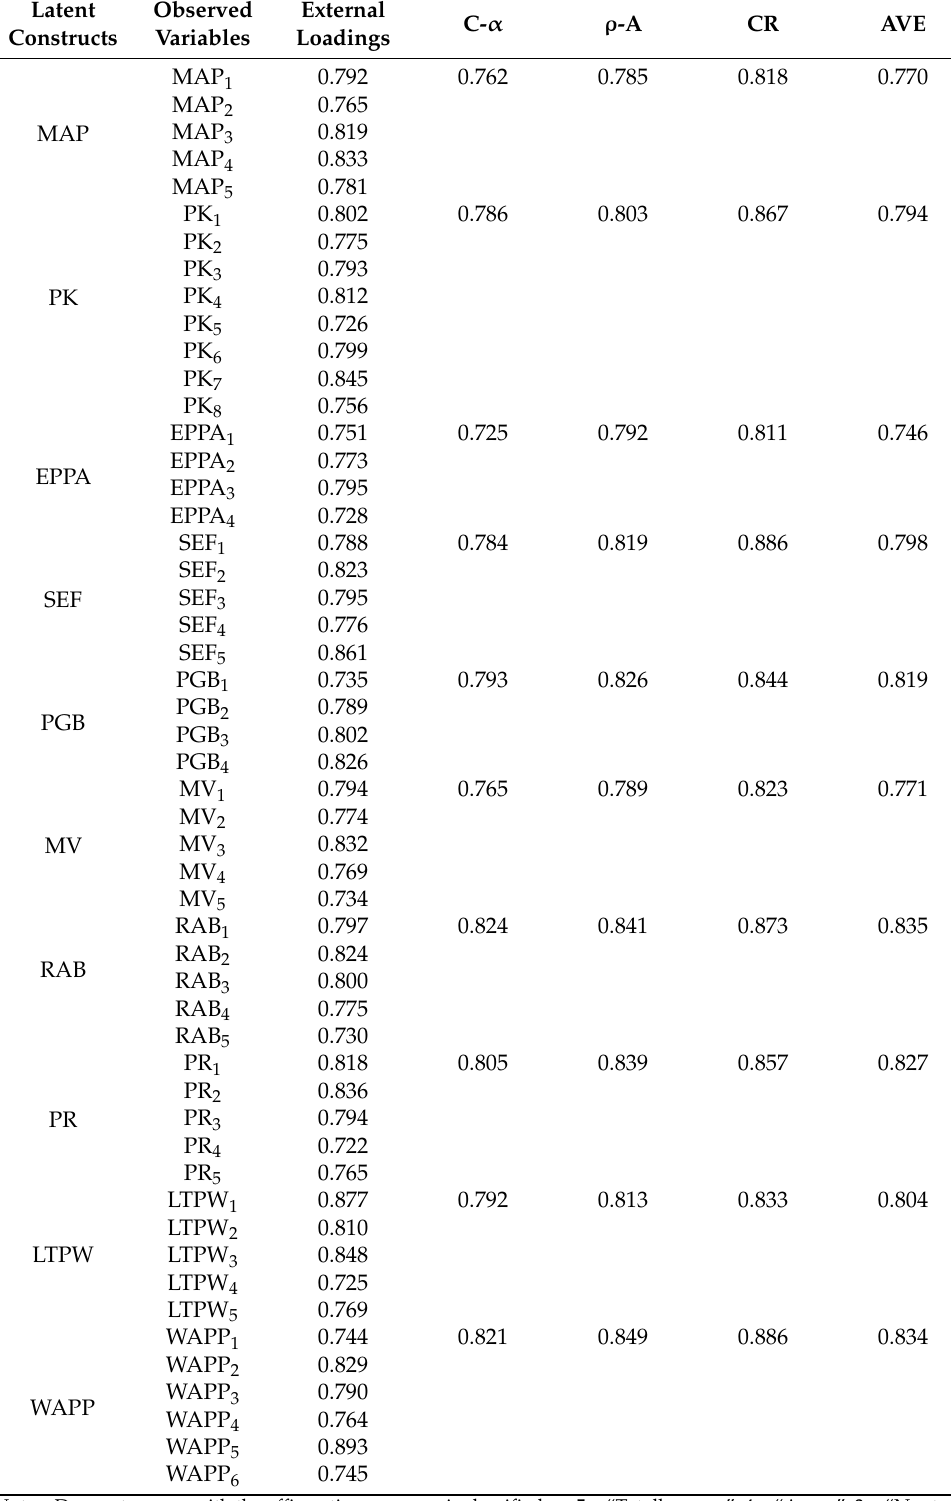
Table 2. Measurement model